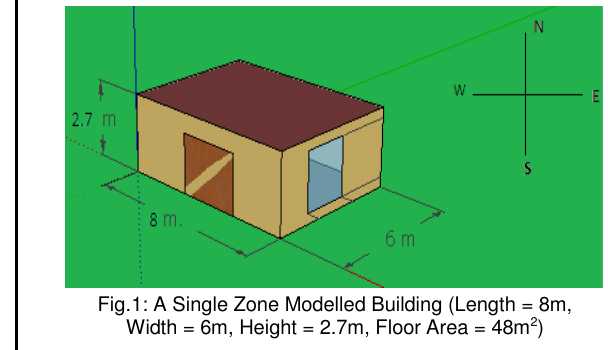
Fig.1: A Single Zone Modelled Building (Length = 8m, Width = 6m, Height = 2.7m, Floor Area = 48m 2